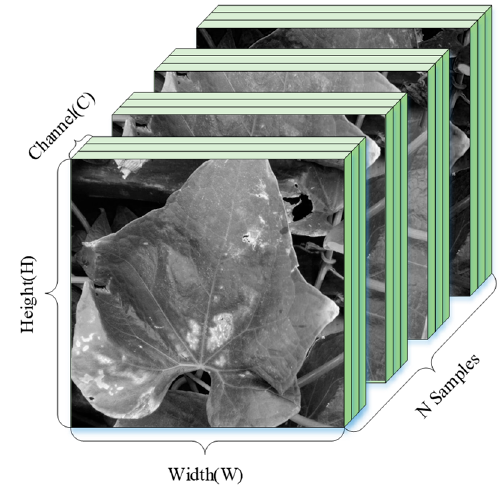
Figure 5. The tensor shape of the input neural network in PyTorch.